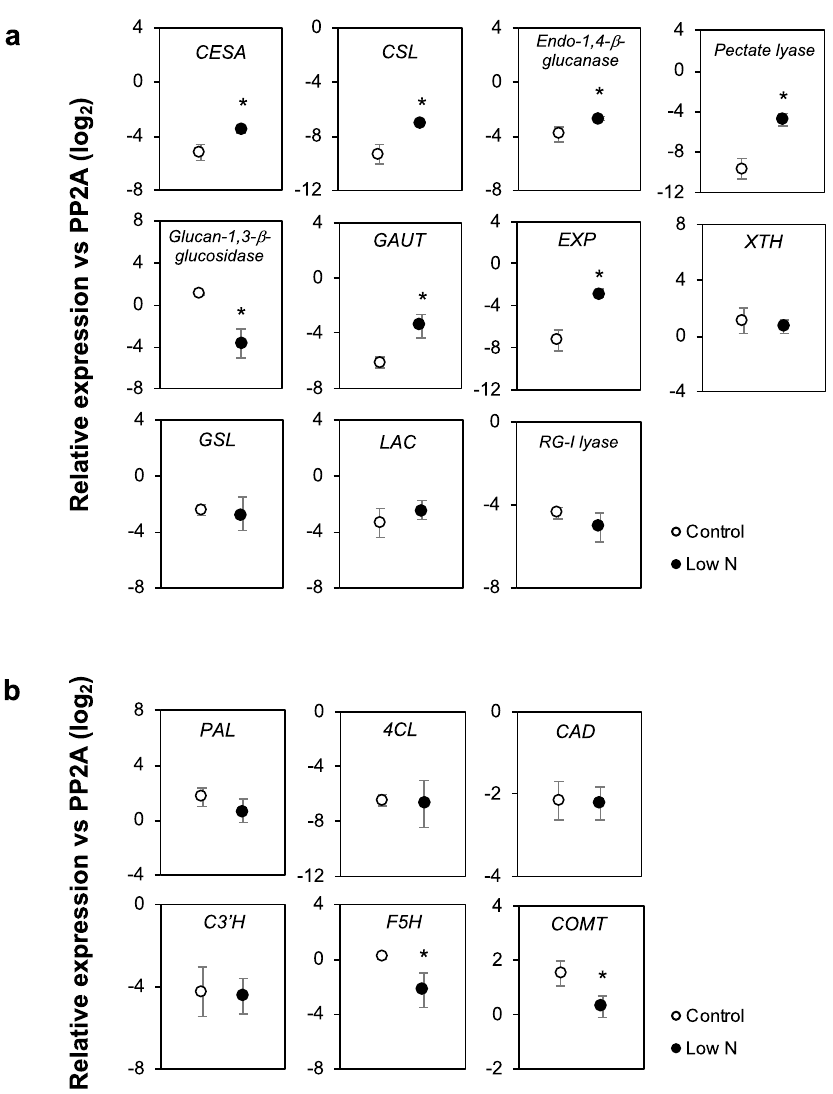
Figure 4. Reverse transcription-quantitative PCR analysis of the expression of selected cell wall-related genes in low nitrogen (N)-treated hydroponically-grown sorghum seedlings. The analysis was conducted at 3 weeks after treatment. ( a ) Polysaccharide metabolism-related genes, and ( b ) lignin biosynthesis-related genes. Genes subjected to the analysis have been listed in Supplementary Table S1. CESA : Cellulose synthase A , CSL : cellulose synthase-like , GAUT : homogalacturonan α-1,4-galacturonosyltransferase , EXP : expansin , XTH : xyloglucan endotransglucosylase/hydrolase , GSL : glucan synthase-like/callose synthase , LAC : laccase , RG-I : rhamnogalacturonan I , PAL : phenylalanine ammonia-lyase , 4CL : 4-coumarate CoA ligase / Brown midrib 2 ( Bmr2 ), CAD : cinnamyl alcohol dehydrogenase / Brown midrib 6 ( Bmr6 ), C3 ʹ H : p- coumaroyl ester 3-hydroxylase , F5H : ferulate 5-hydroxylase (= coniferaldehyde 5-hydroxylase , CAld5H ), and COMT : caffeate/5-hydroxyferulate O -methyltransferase (= 5-hydroxyconiferaldehyde O -methyltransferase , CAldOMT )/ Brown midrib 12 ( Bmr12 ). The expression of each gene was analyzed as transcript abundance relative to PP2A (XM_002453490). Values are means ± SD (n = 3). Asterisks indicate significant differences between control and low-N plants. (Student’s t test, p <